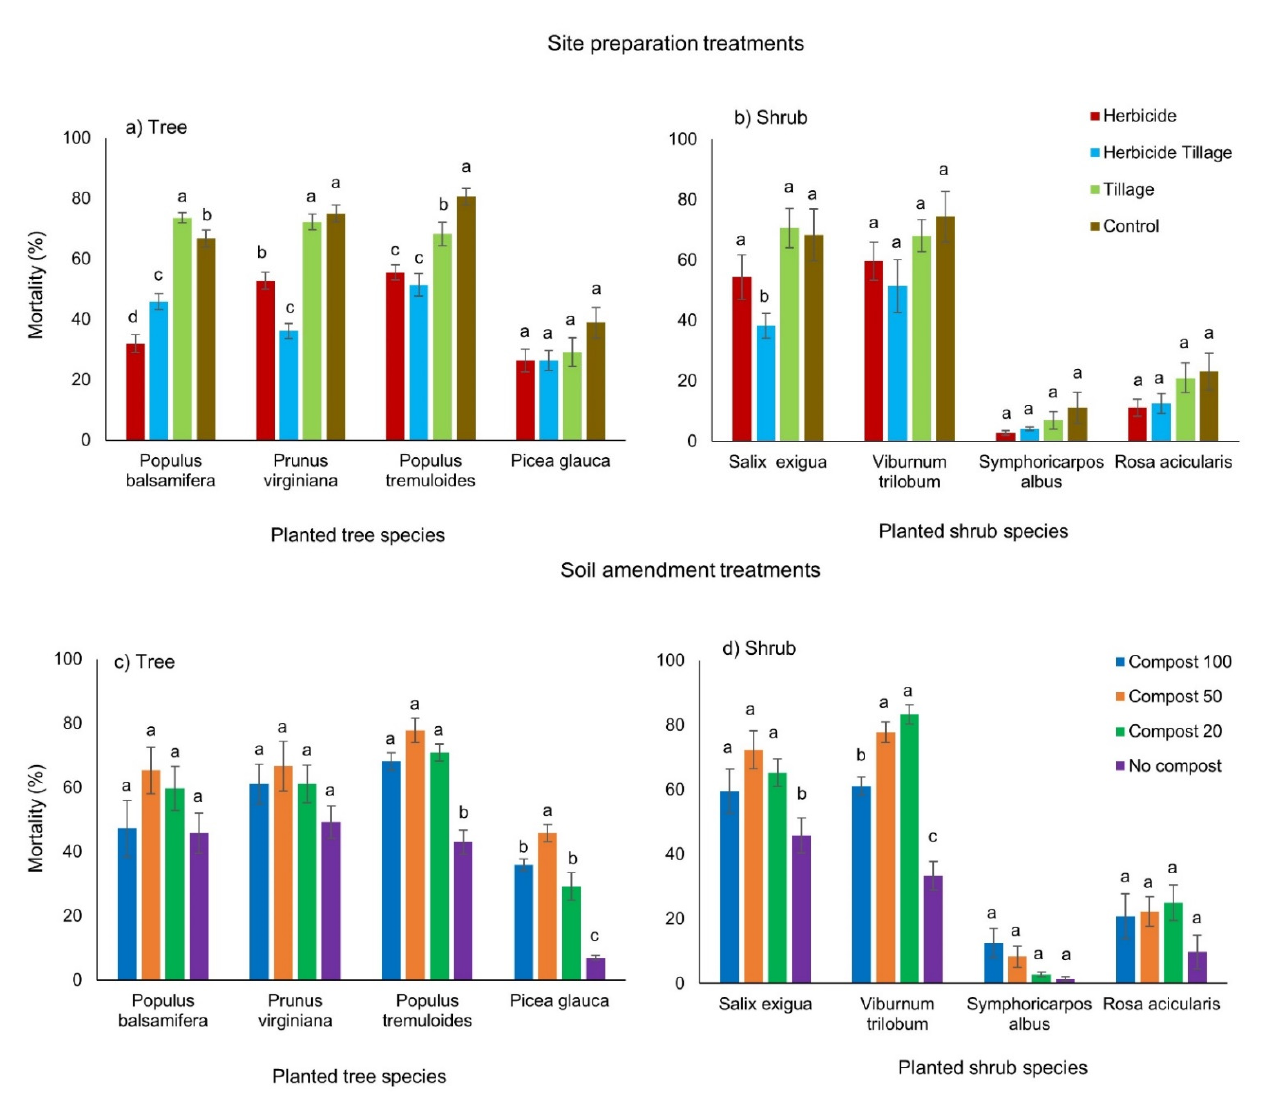
Figure 3. ( a – d ) Mean ( ± SE) mortality percent of individual tree and shrub by site preparations and soil amendments. Different letters within species indicated significance difference at α = 0.05.